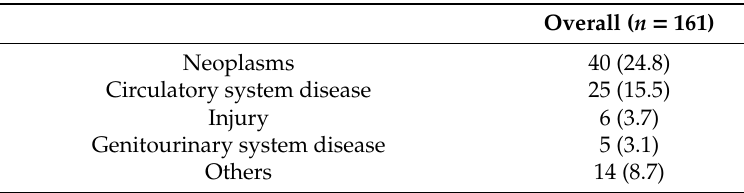
Table 2. Several prediction models in a five-fold cross validation.